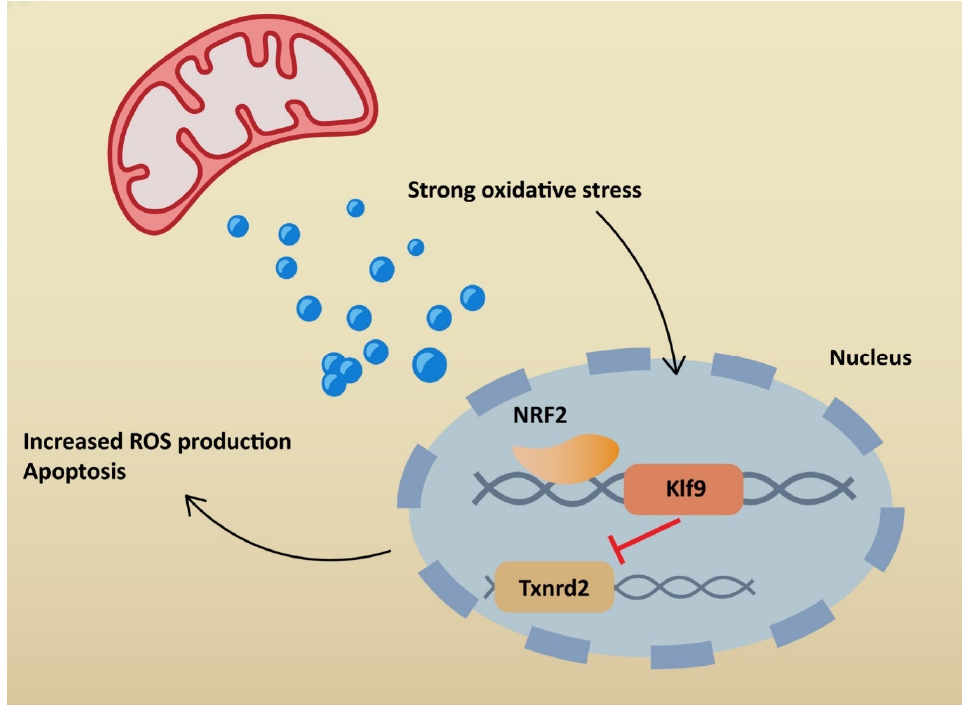
Figure 4. Cellular effects of high-dose ROS stimulation: ROS—reactive oxygen species; NRF2—nuclear factor erythroid 2-related factor 2; KLF9—Kruppel-like factor 9; TXNRD2—thioredoxin reductase 2.